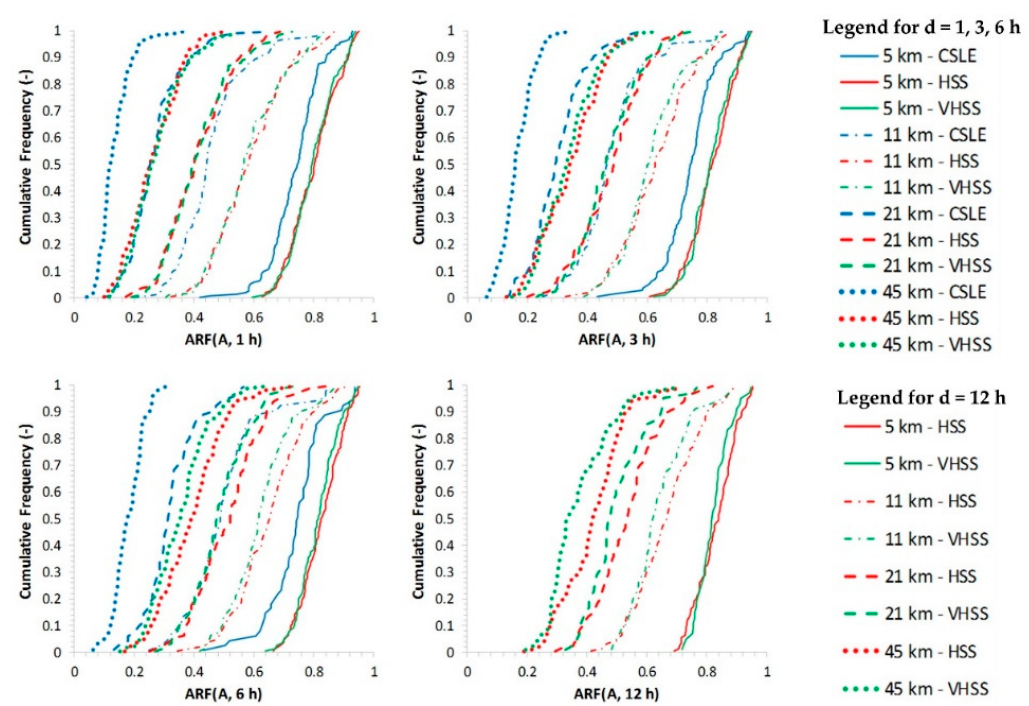
Figure 9. Comparison of cumulative frequency distributions for Areal Reduction Factors (ARFs), by fixing d and varying A.